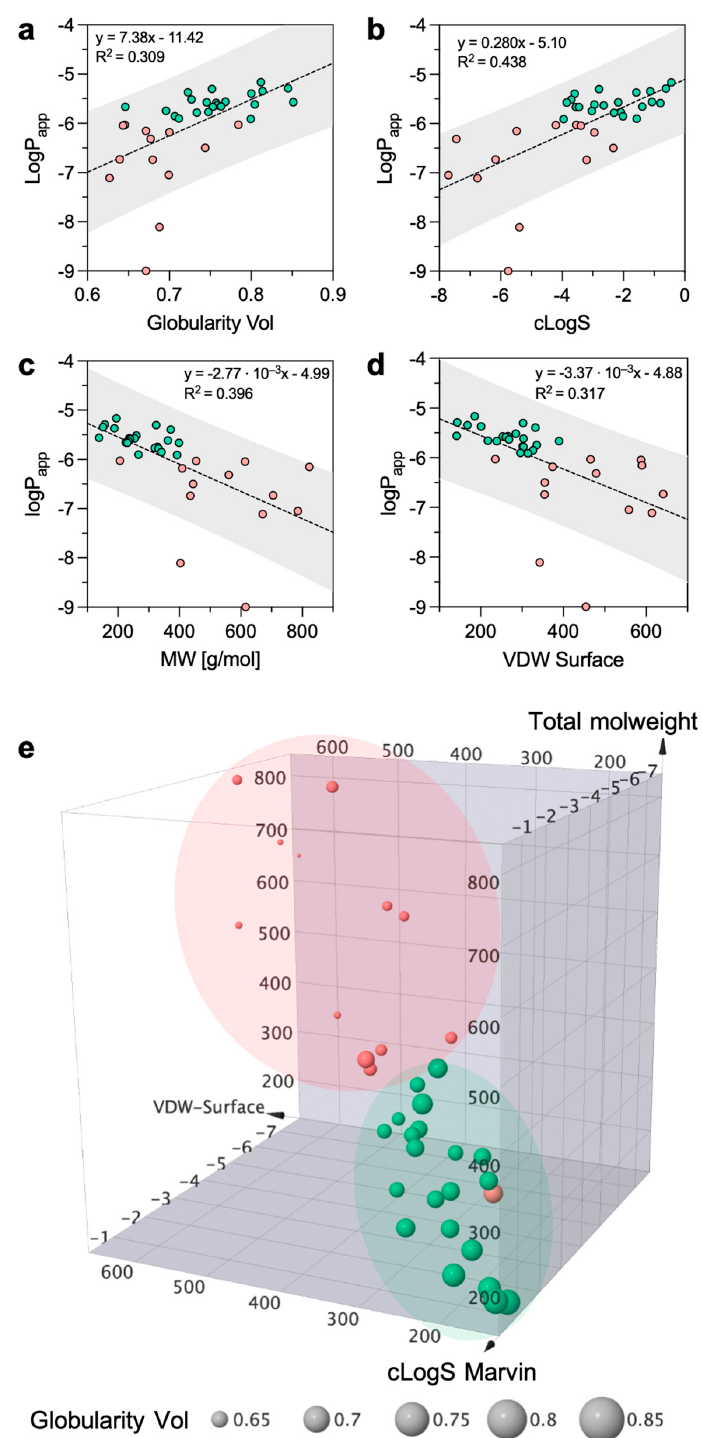
Figure 4. Two-dimensional plots of the logarithm of apparent permeability ( P app ) versus ( a ) globularity (globularity Vol), ( b ) intrinsic solubility (cLogS), ( c ) molecular weight (MW), and ( d ) the Van der Waals Surface (VDW Surface). The gray area represents the prediction bands using a 90% confidence level. ( e ) Three-dimensional plot depicting the chemical space of the dataset as defined by cLogS, MW, and VDW Surface. The marker is sized by globularity volume. A binary color code is used to distinguish between high- (green) and low- (red) permeability compounds.